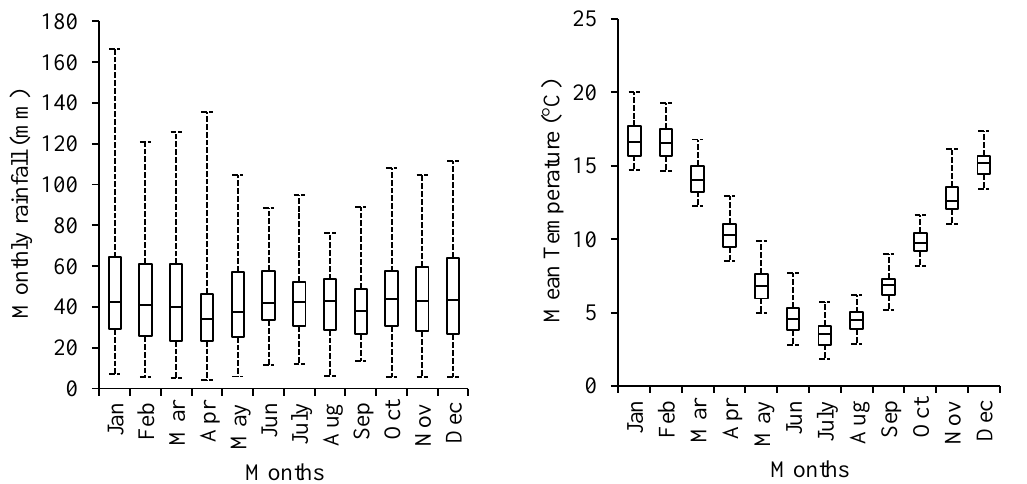
Figure 2. Box and plot chart of the annual variation of monthly rainfall and mean temperature values based on CRU TS dataset for the NSW, region from 1901 to 2018.